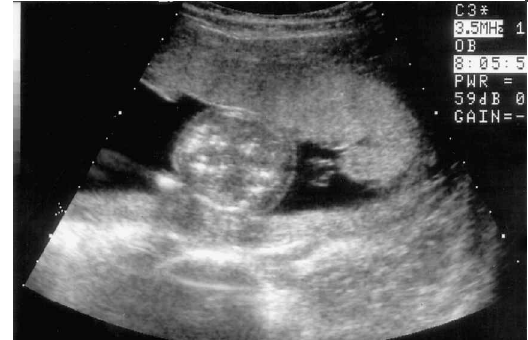
Figure 1 Sonogram of cross-section of fetal abdomen showing subcutaneous edema and echodensities in fetal